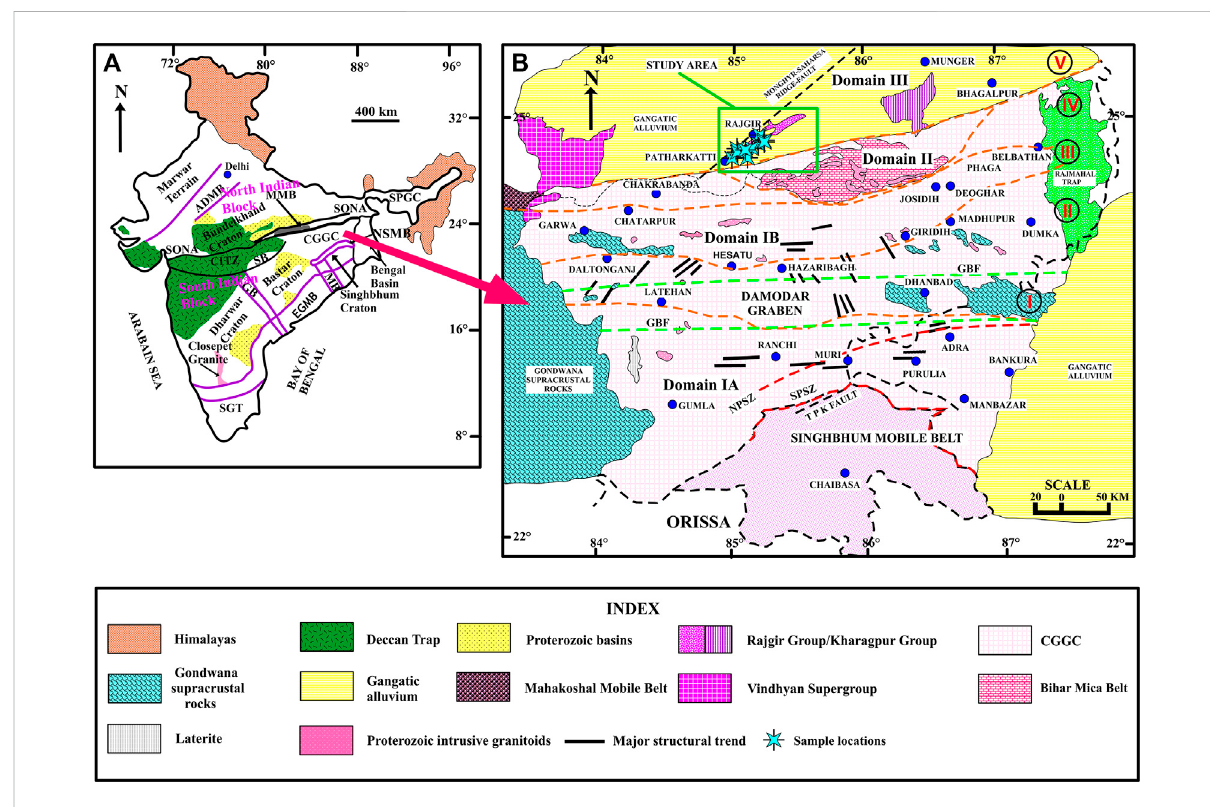
FIGURE 1 (A) map of India showing the location of the Central Indian Tectonic Zone (CITZ) along with other Proterozoic mobile belts of India, including the Eastern Ghats Mobile Belt and the Aravalli Delhi Mobile Belt. The CITZ comprises the central CITZ, the Chotanagpur Granite Gneiss Complex (CGGC), and the easternmost Shillong Plateau Gneissic Complex. Four Archaean cratonic nuclei of India, namely, Singhbhum, Bastar, Bundelkhand, and Dharwar, are also shown (modi fi ed after Pradhan et al., 2009). GB, Godavari Basin; MB, Mahanadi Basin; MMB, Mahakoshal Mobile Belt; SB, Satpura Basin; NSMB, North Singhbhum Mobile Belt; SGT, Southern Granulite Terrain. (B) map of CGGC modi fi ed after Sanyal and Sengupta 2012 showing the fi ve subdivisions of CGGC, namely, (I) Ranchi – Purulia, (II) Hazaribagh – Dumka, (III) Giridih – Deoghar, (IV) Bihar Mica Belt, and (V) Rajgir – Kharagpur subdivisions as proposed by Mahadevan (2002) delineated by orange lines. Also shown in the map are current subdivisions of CGGC proposed by Mukherjee et al. (2019) marked as Domain I (IA and IB), Domain II, and Domain III. The green square box shows the study